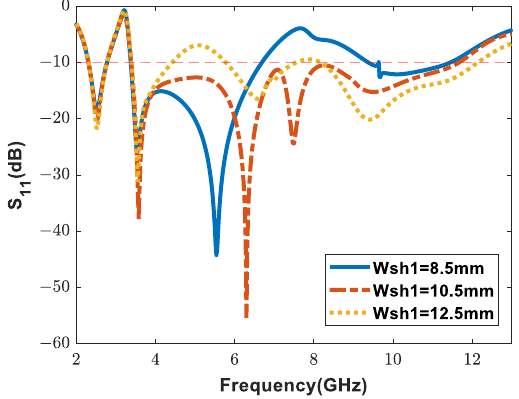
Figure 6. S-parameter according to the size of Wsh1.